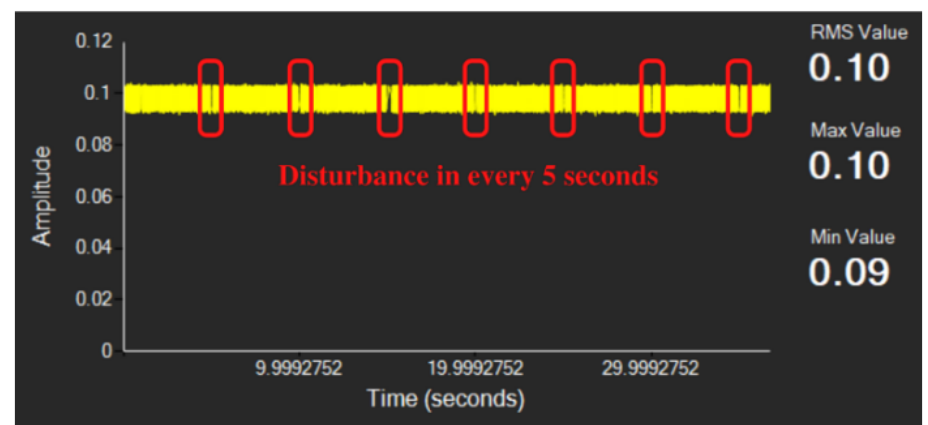
Figure 13. Disturbance during continuous synchronization.